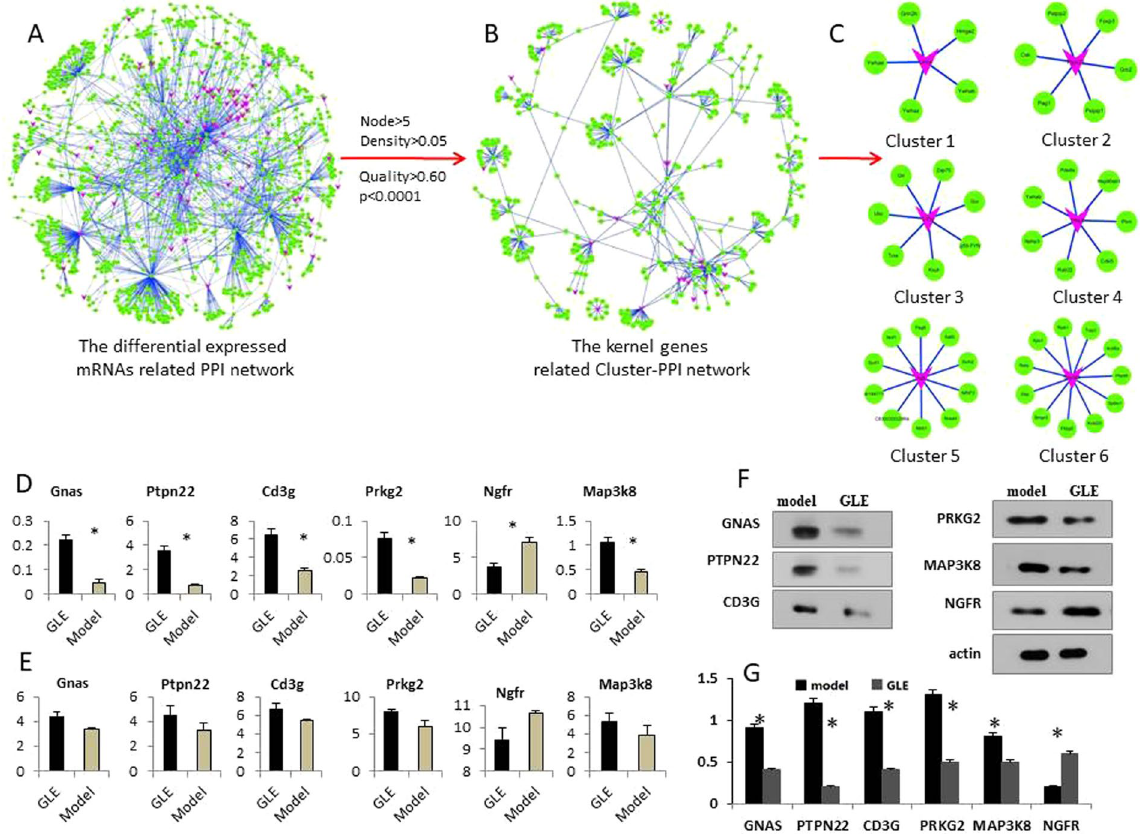
Figure 5. The protein-protein interaction (PPI) network was constructed based on DE mRNAs, the related clusters were identified using ClusterONE algorithm. ( A ) The global profiles of GLE treatment related PPI network was built. The red nodes represent the differential expressed mRNAs. ( B ) The topological profile of GLE treatment related Cluster-PPI network, the red nodes represent the differential expressed mRNAs. ( C ) The kernel mRNA clusters isolated from Cluster-PPI network. ( D ) The qRT-PCR was used to validate 6 potential kernel mRNAs, and the expression levels of 6 kernel mRNAs have statistically significant difference in GLE treated Hepa1-6-bearing C57 BL/6 mice. ( E ) The expression tendency of 6 kernel mRNAs in the microarray. ( F , G ) Western-blot assay was used to further validate the 6 kernel mRNAs. Representative results of three independent experiments are shown. Error bars, * P < 0.01 versus model values. Representative results of three independent experiments are shown. The β -actin was used as a loading control. Error bars, * P < 0.01 versus model